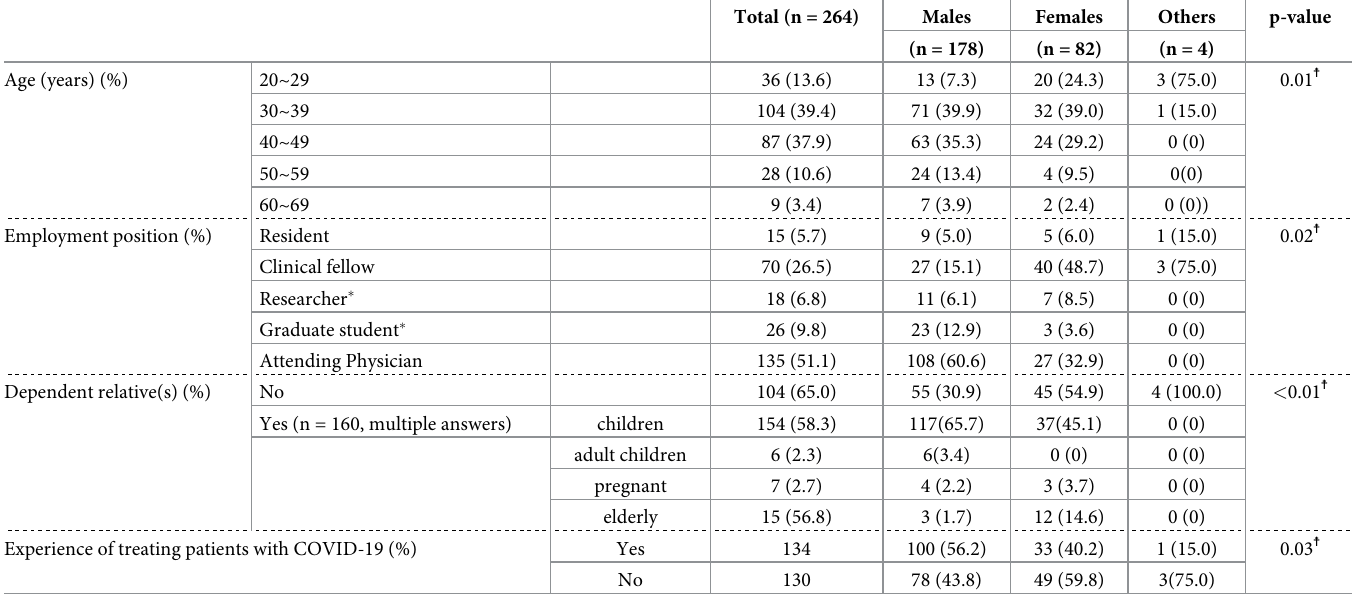
Table 1. Characteristics of all responders in the questionnaire